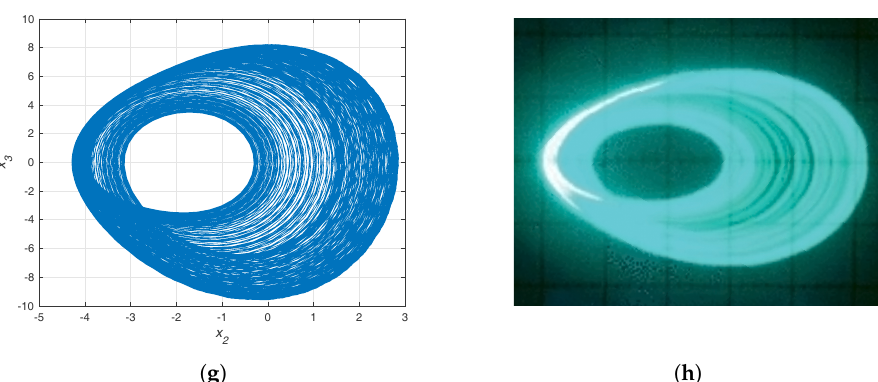
Figure 12. Numerical ( left ) vs. Experimental ( right ) results: ( a , b ) Period 1 or Limit Cycle Attractor case for β = 9 & R 6 = 1112 Ω , ( c , d ) Period 2 Attractor case for β = 6 & R 6 = 1667 Ω , ( e , f ) Period 4 Attractor case for β = 5.84 & R 6 = 1715 Ω , ( g , h ) Chaotic Attractor case for β = 5.535 & R 6 = 1807 Ω